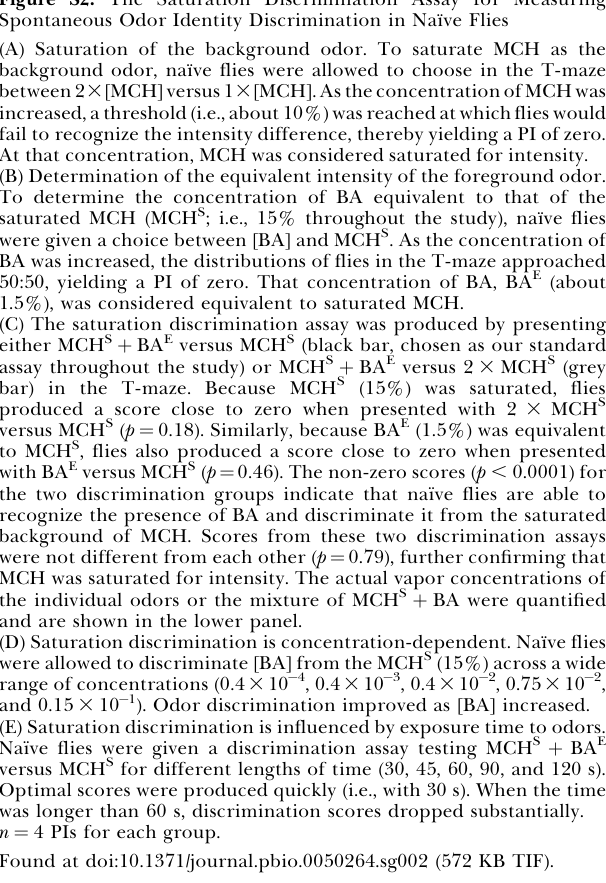
Figure S3. Spontaneous Discrimination between Chemically Differ- ent Odors